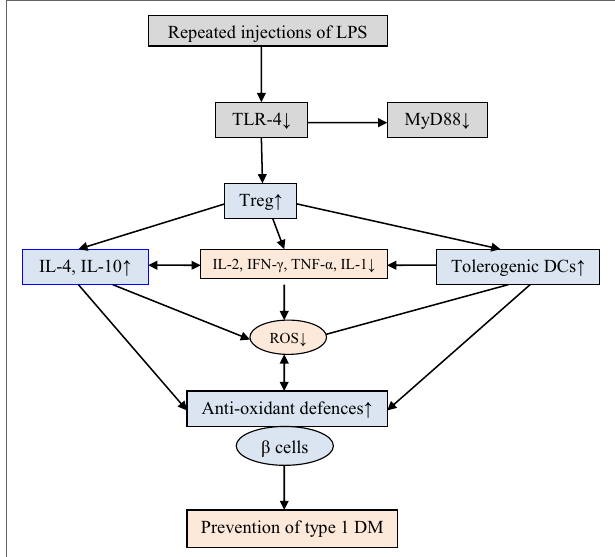
FiGUre 2 | Multiple-injections of lipopolysaccharide (LPS) is effective in preventing type 1 diabetes mellitus (type 1 DM). LPS administration suppresses spleen T lymphocyte proliferation, increases the generation of T regulatory, reduces the synthesis of T-helper 1 pro-inflammatory cytokines [interleukin-2 (IL-2), interleukin-1 (IL-1), interferon- γ (IFN- γ ), and tumor necrosis factor- α (TNF- α )], and downregulates toll-like receptor-4 (TLR-4) and its downstream MyD88-dependent signaling pathway and enhances IL-4 and IL-10 and antioxidant defenses. Multiple injections of LPS induce tolerogenic dendritic cell (DC) subset with low TLR-4 expression and, thus, prevent development of type 1 DM in non-obese diabetic mice [see text and Wang et al.